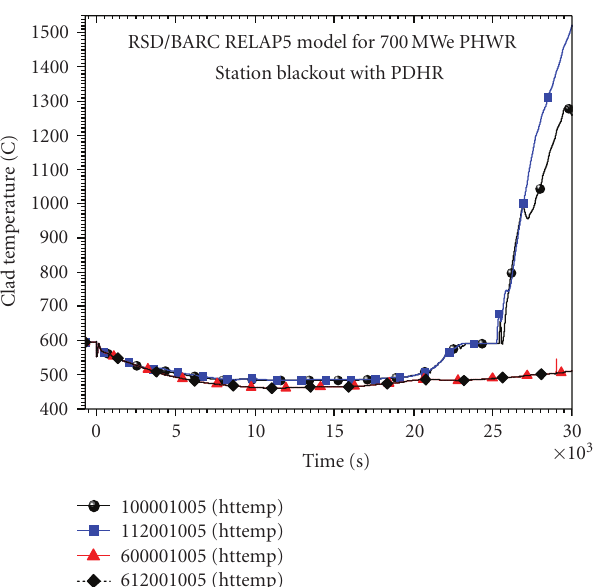
Figure 19: Clad temperature case-3PDHRs with no loop isolation.